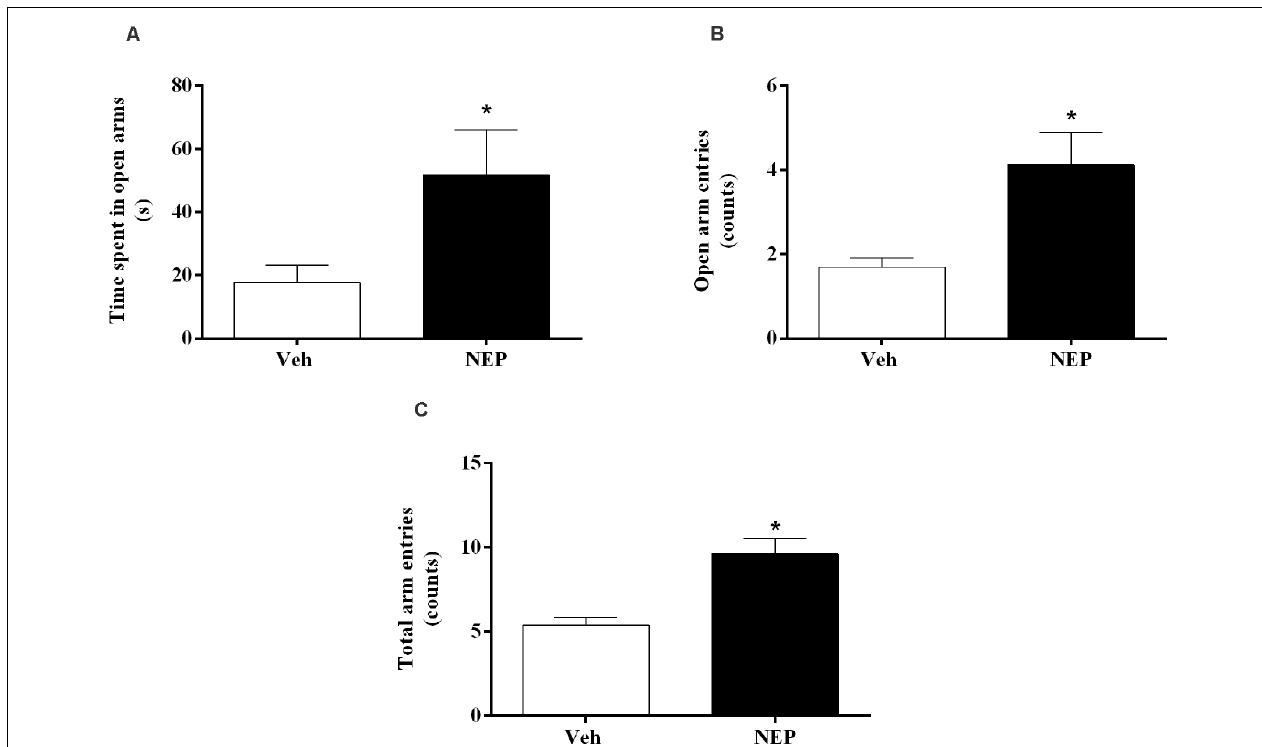
FIGURE 3 | (A) Time spent in open arms, (B) open arm entries, and (C) total arm entries of the elevated plus maze test, on day 9 after post-traumatic stress disorder (PTSD) induction. Values are means ± SEM of eight mice per group. Veh, mice in the PTSD-group and treated with vehicle; NEP, mice in the PTSD-group and treated with nepicastat; *, significantly different from correspondent values in mice in the PTSD-group and treated with vehicle ( p < 0.05).